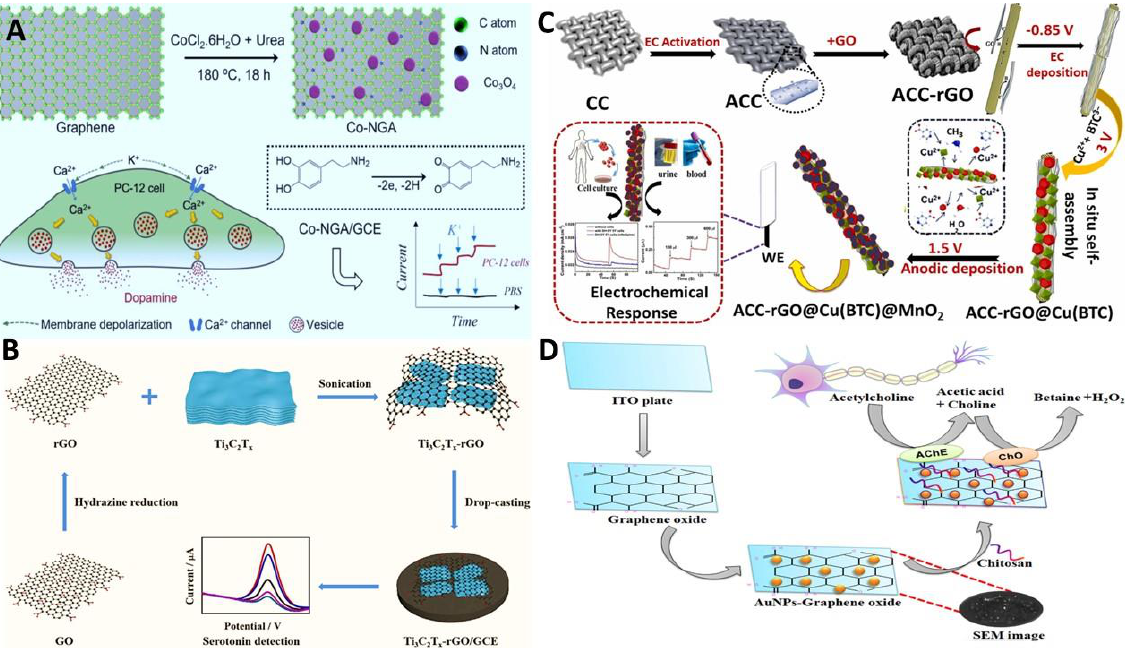
Figure 4. ( A ) Drawing of Co-NGA and Co-NGA/GCE used to detect DA secreted by live cells. Reprinted with permission from [108]. ( B ) Synthesis of Ti 3 C 2 T x -RGO NC and its EC response for ST detection using GCE. Reprinted with permission from [125]. ( C ) Schematic of ACC- RGO@Cu(BTC)@ α -MnO 2 based flexible electrode prepared by anodic-induced electrodeposition and EC detection of Ach from biological matrices. Reprinted with permission from [127]. ( D ) Depiction of Ach detection mechanism on the Surface of ITO-Au NPs-GO modified electrode. Reprinted with Table 1. EC sensors based on GR NCs for various bioanalytes detection.